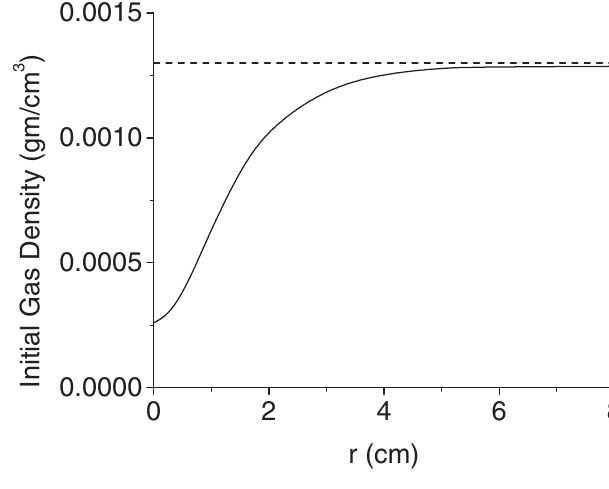
FIG. 13. Initial neutral gas density profile for reduced-density channel simulation (solid line) and nominal gas density profile (cid:6) 2 cm . (dashed 0